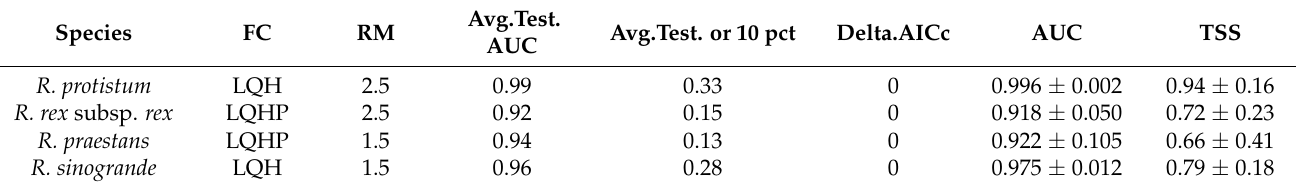
Table 3. The models calculate the results of Wallace package, as well as the values of AUC and TSS for four Rhododendron species. FC: Feature classes (H = Hinge, L = Linear, Q = Quadratic, p = Hinge); RM: Regularization multiplier; avg.test.AUC: The average result of n iterations of predicted values for the test localities; avg.test.or10 pct: The proportion of test localities with suitability values that is lower than what is excluded in the 10% of training localities with the lowest predicted suitability; delta. AICc: Akaike Information Criterion